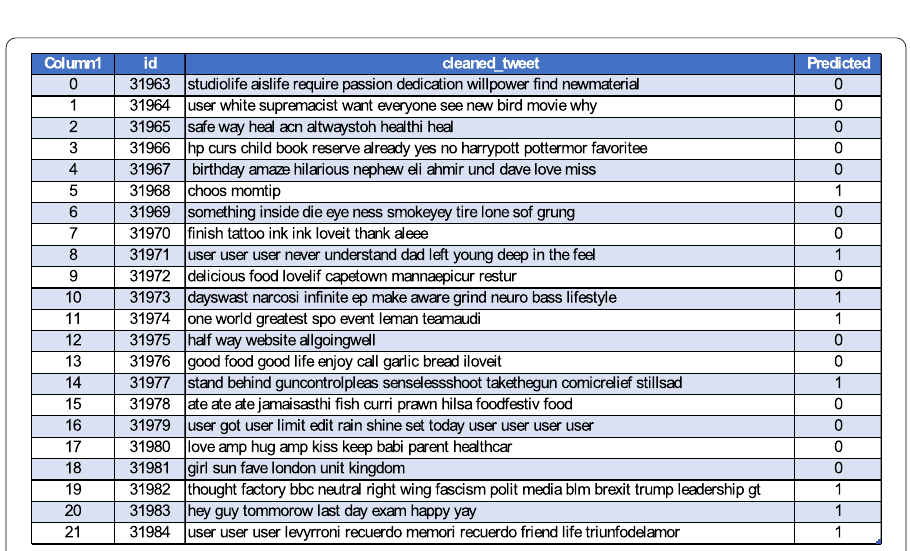
Fig. 18 Output Excel file after Binary Sentiment Analysis using Random